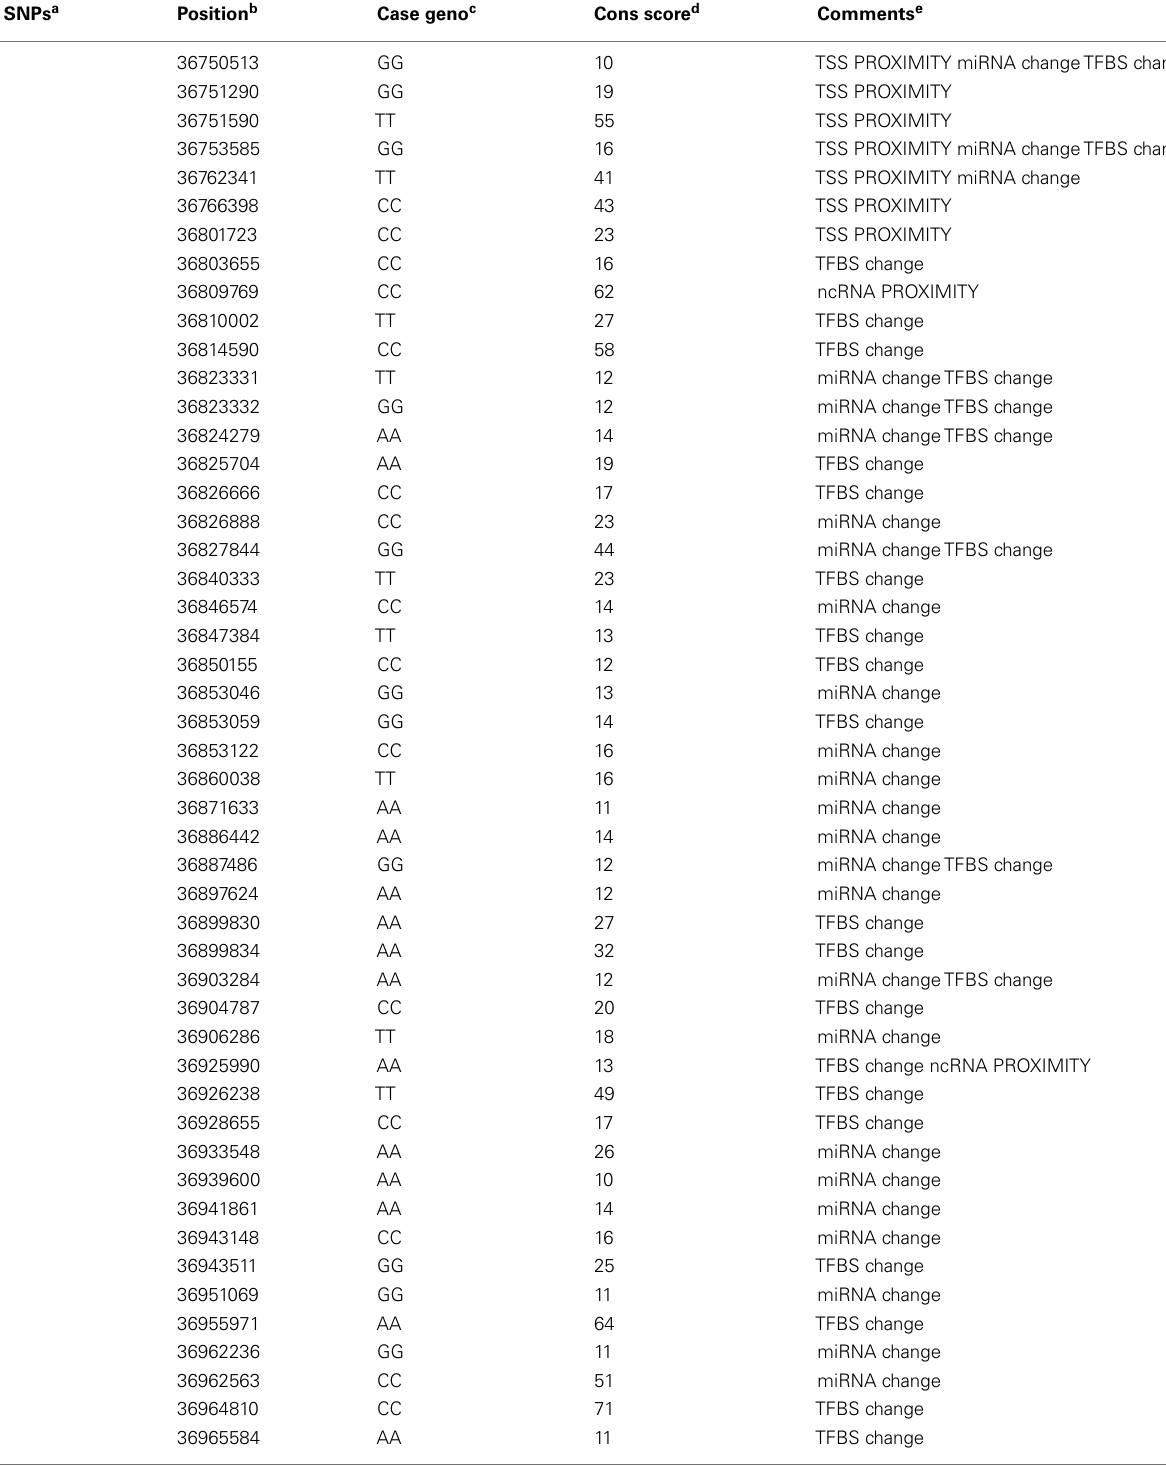
TableA1 | Functional prediction of SNPs homozygous in the case sorted according to genomic position. TaqMan SNPs